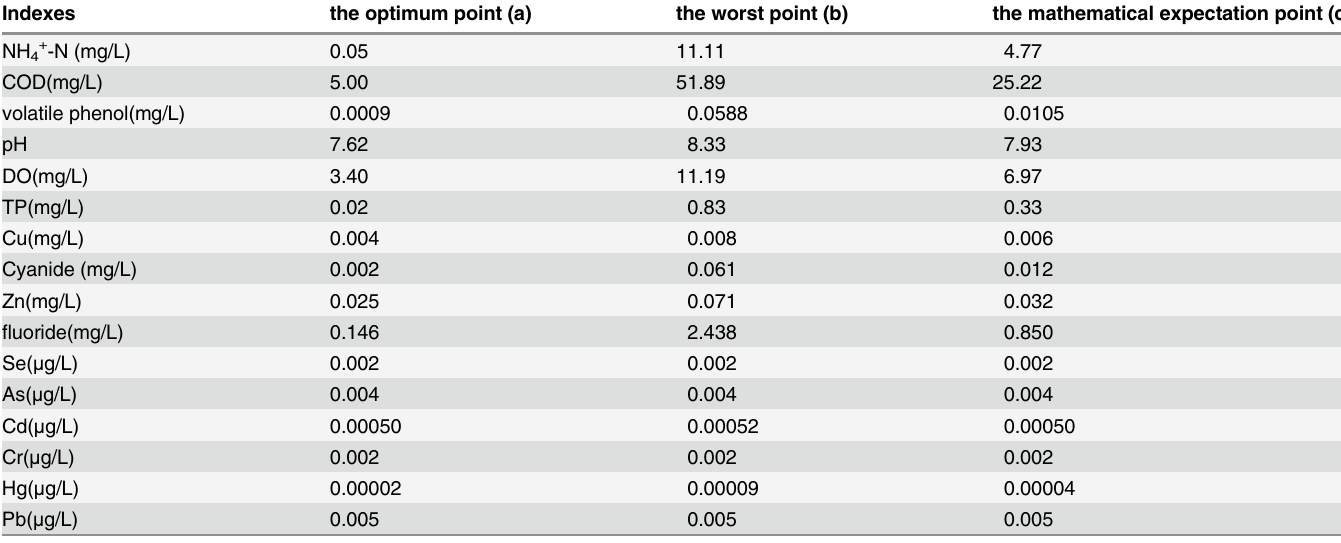
The verification on the result of water quality monitoring optimization Based on the water quality monitoring data from July 2010 to December 2010, the difference between un-optimized monitoring networks and optimized monitoring networks were com- pared by F-test (variance test) and T-test (mean test). Significance level was 0.05, and the main pollutants (COD, NH 4+ -N and volatile phenol) were chosen as sample variable. The results of the test were shown in Table 6. The results of F-test on COD, NH 4+ -N and volatile phenol were homoscedastic and the results of T-test on the main pollutants have no significant differences. There were no significant differences between non-optimized monitoring networks and opti- mized monitoring networks. So the optimized monitoring networks by matter element analysis could correctly represent the original monitoring network. At the same time, it was highly-effi- cient and more economic. Table 4. The numerical value of the most ideal point (a), the least ideal point (b) and the mathematical expectation point (c). Indexes the optimum point (a) the worst point (b) the mathematical expectation point